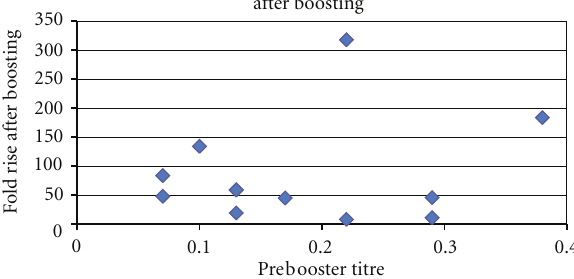
Figure 4: Scatter plot of pre-booster tire and fold rise in titre after